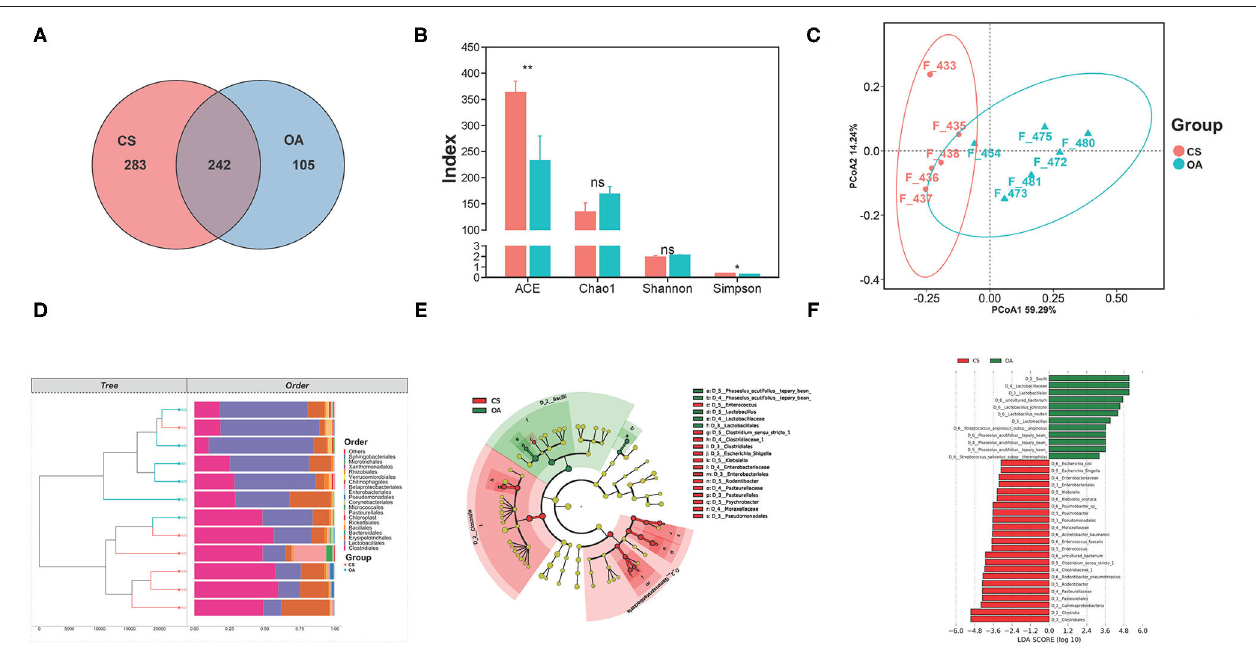
FIGURE 5 | (A) Venn diagram of the OA and CS groups at OTUs level. (B) Effects of CS on the alpha diversity of the gut microbiota from the OA rats. (C) The PCA plot of samples from the OA and CS groups. (D) Clustering analysis (at order level) of the gut microbiota among samples from the OA and CS groups. (E) Linear discriminant analysis effect size. (F) Taxonomic cladogram derived from LEfSe with an LDA score > 2.0. The symbols indicate statistical significance: ns ( P > 0.05), * P ≤ 0.05, ** P ≤